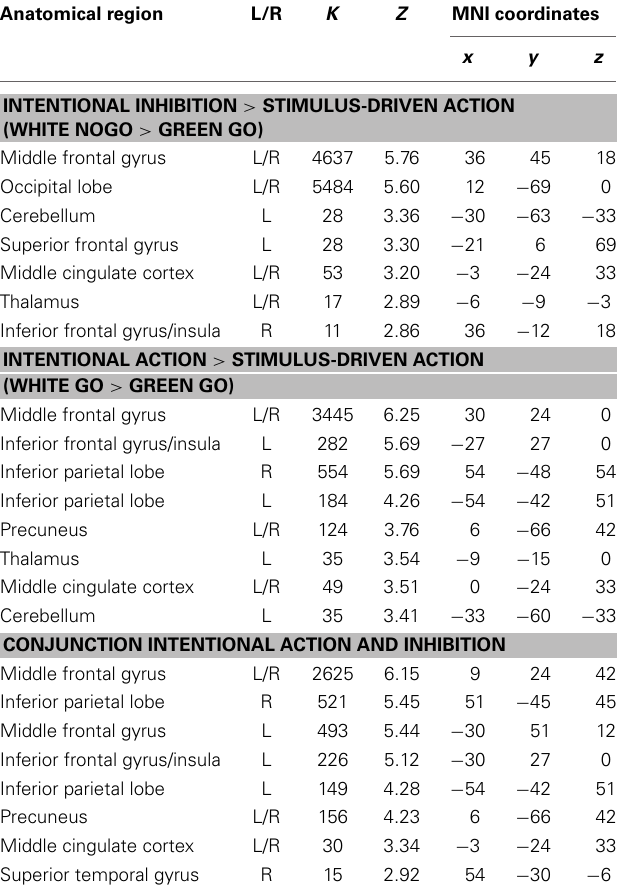
Table 1 | Brain regions revealed by whole brain contrast, focused on decision processes (all FDR corrected, p < 0 . 05, > 10 voxels).